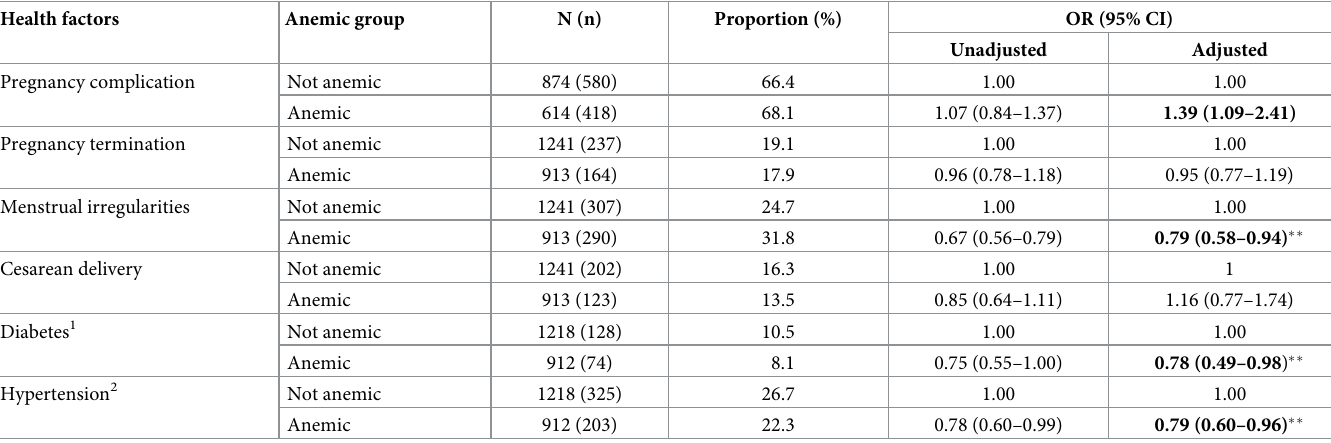
The associations between maternal anemia and adverse birth outcomes are presented in Table 4. We found 1.87 times (AOR, 1.87, 95% CI, 1.06–5.10) higher likelihood of early neona- tal deaths among newborns of anemic mothers as compared to the newborn of non-anemic Table 3. Unadjusted and adjusted relation between maternal anemia and adverse maternal health outcomes,